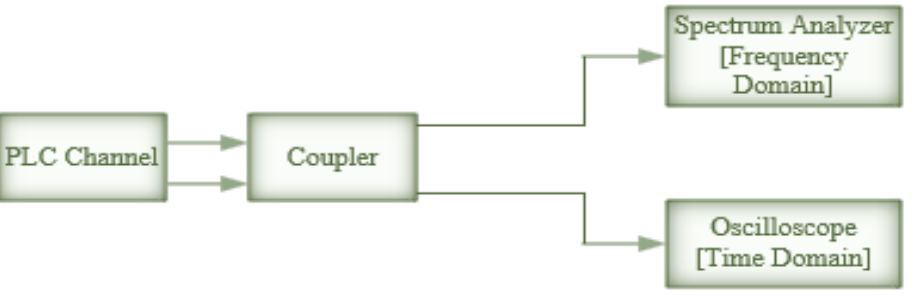
Figure 6. Noise measurement block diagram.